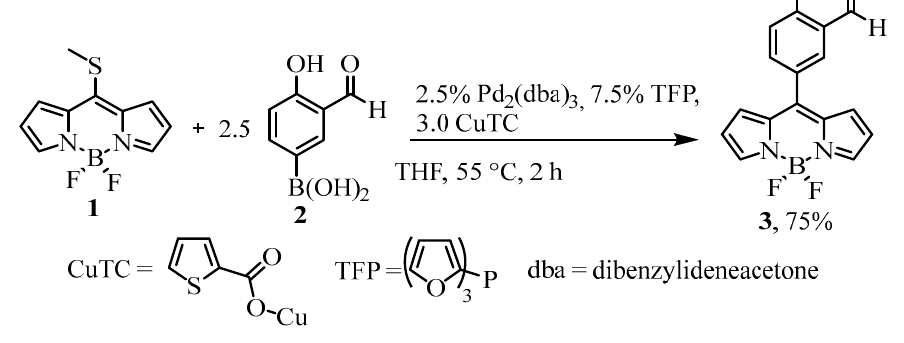
Figure 1. Structure of boron dipyrromethene dyes (BODIPYs) and coumarins.